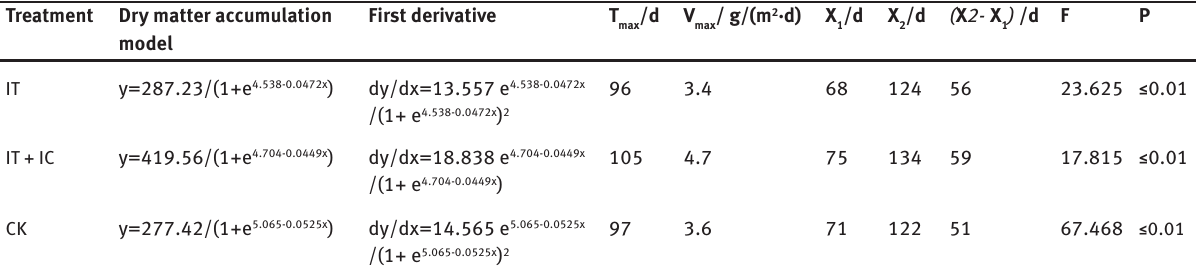
Table 4: Dynamic simulation and characteristic parameters of dry matter accumulation for potato aboveground part in different treatments.